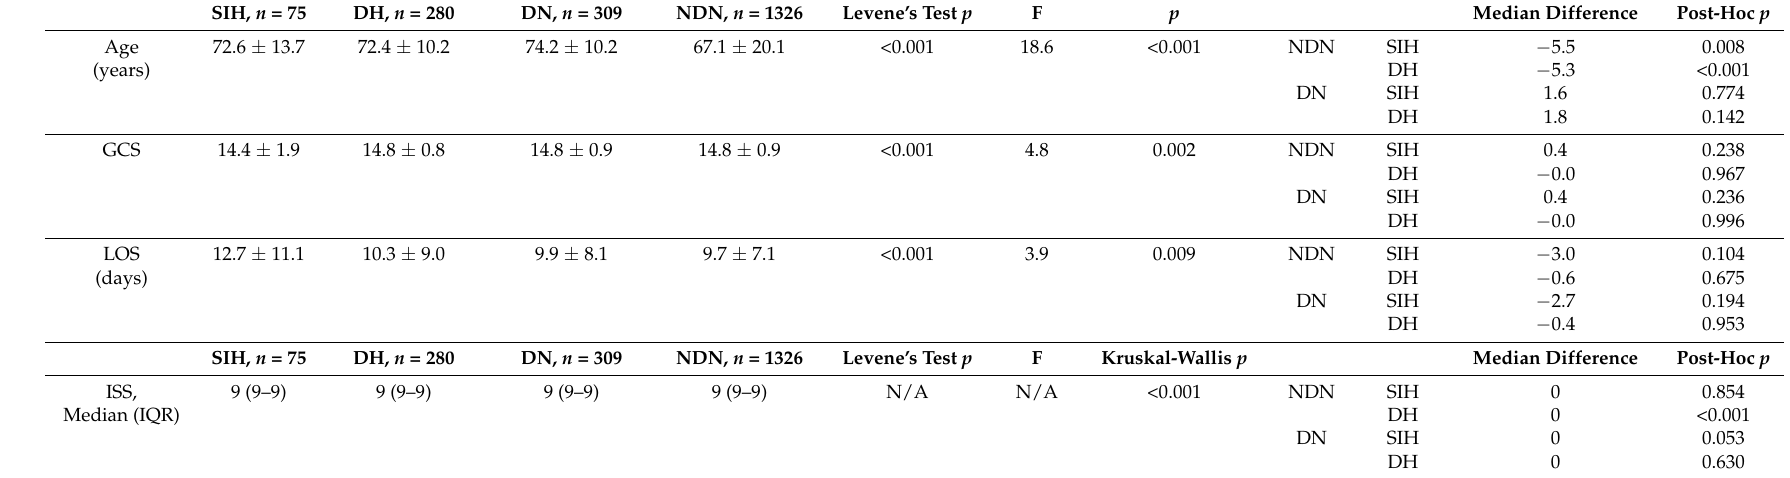
Table 3. Comparison of characteristics and outcomes of continuous variables between patient